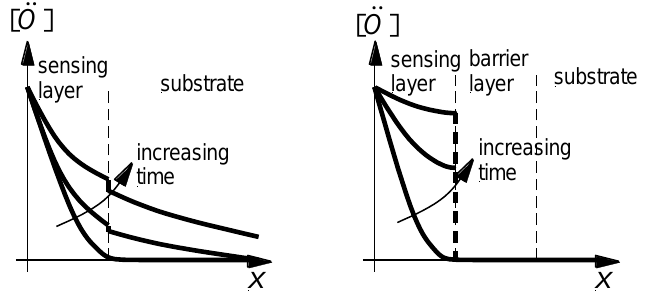
Figure 16. Oxygen profiles ( Left ) without barrier layer and ( Right ) with barrier